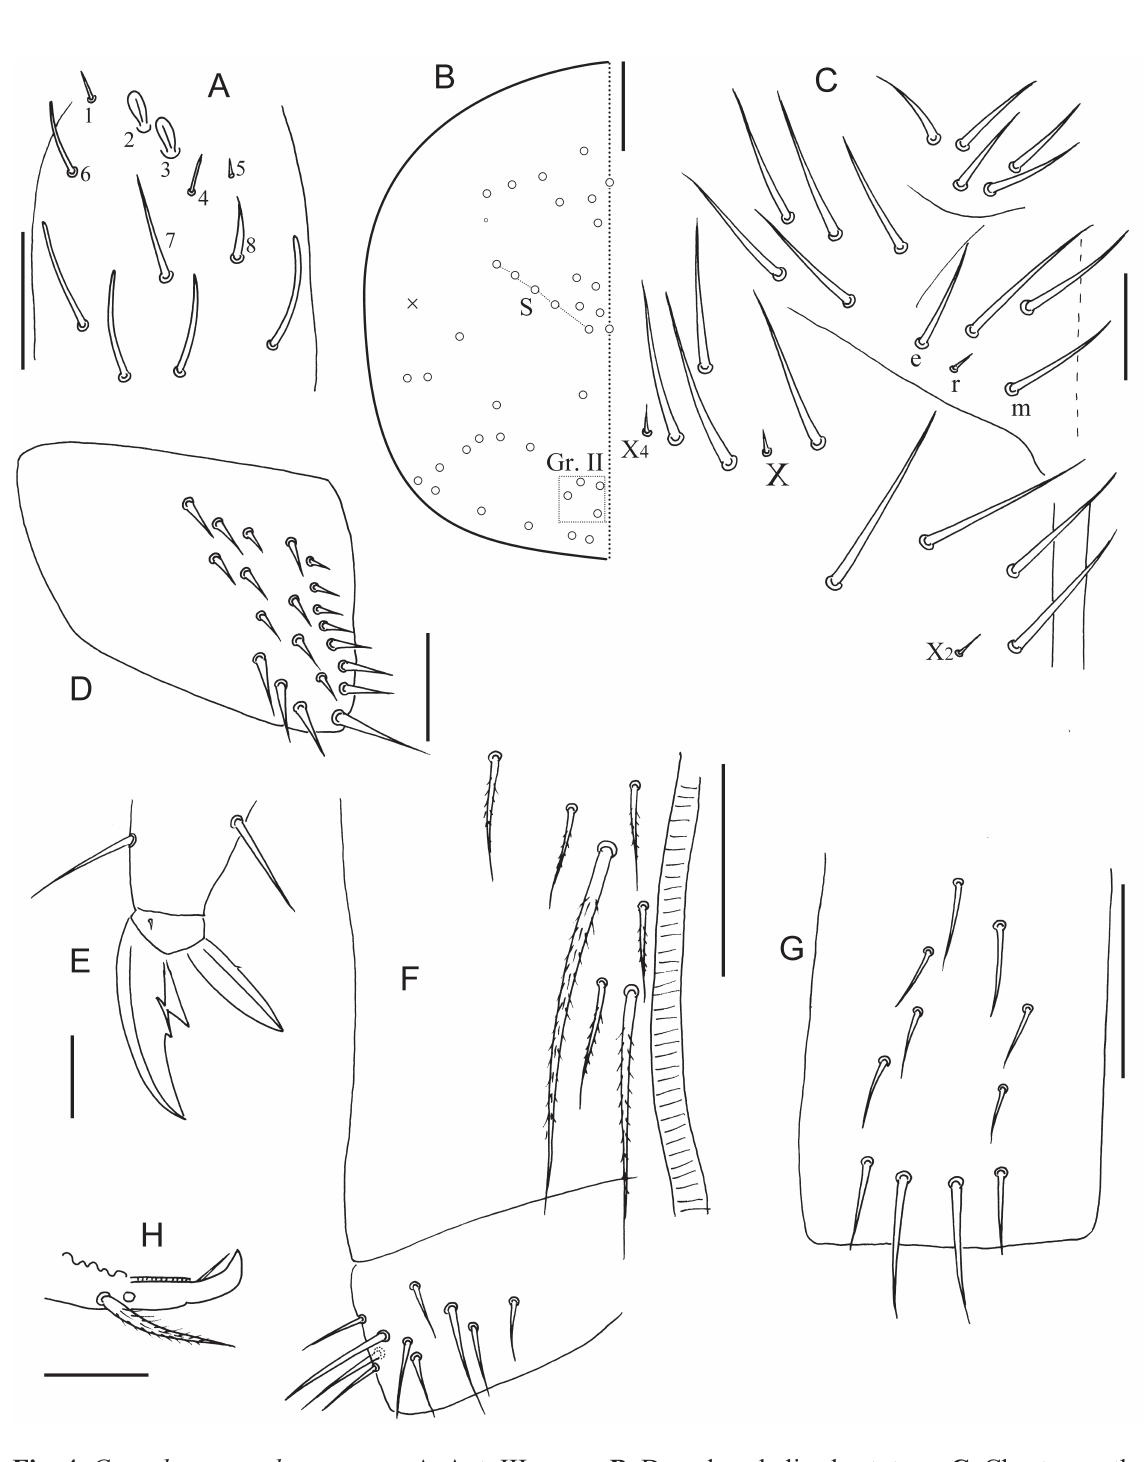
Fig. 4. Coecobrya annulata sp. nov. A . Ant. III organ. B . Dorsal cephalic chaetotaxy. C . Chaetae on the ventral side of head. D . Trochanteral organ, ventral view. E . Hind claw. F . Anterior face and lateral flap of ventral tube. G . Posterior face of ventral tube. H . Mucro. Scale bars: A, C‒E, H = 50 μm; B, F–G = 100